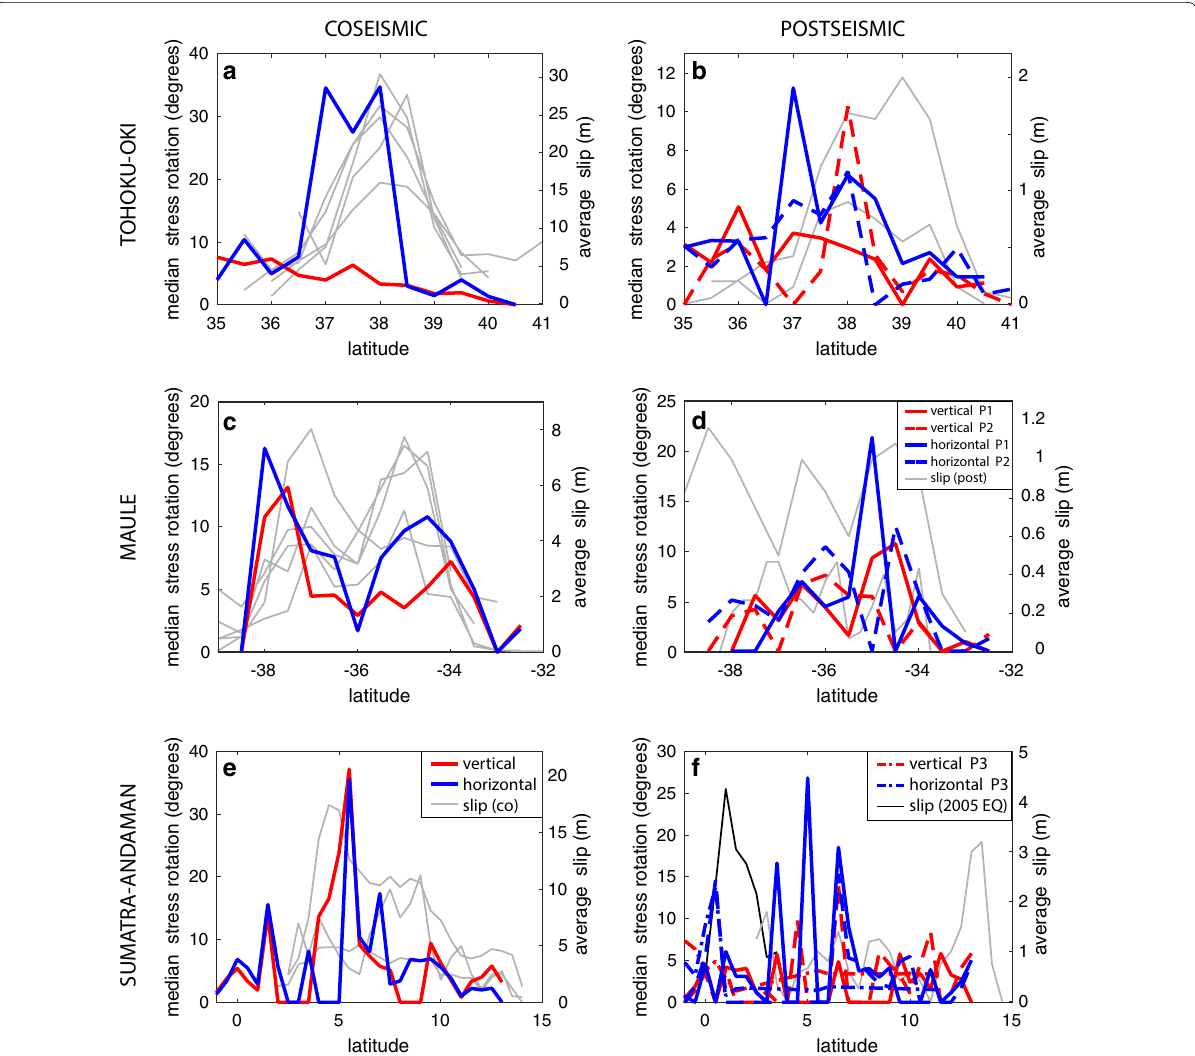
Fig. 5 Stress rotation as a function of latitude, a proxy for along-strike distance. The median vertical ( red ) and horizontal ( blue ) stress rotation is found for all inversion bins in 0.5° latitude intervals. Multiple realizations are performed by sampling a rotation for each bin from its bootstrap uncertainty, and the median is set to zero if it is not significantly different from zero at 1-sigma uncertainty. Gray curves indicate average mainshock slip or average afterslip as a function of latitude, from the same models as in Fig. 4. a Tohoku-Oki earthquake coseismic stress rotation, b Tohoku- Oki earthquake postseismic stress rotation, P1 shown as solid lines and P2 as dashed lines , c Maule earthquake coseismic stress rotation, d Maule earthquake postseismic stress rotation, P1 shown as solid lines and P2 as dashed lines , e Sumatra–Andaman earthquake coseismic stress rotation. f Sumatra–Andaman earthquake postseismic stress rotation, P1 shown as solid lines , P2 as dashed lines , and P3 as dash - dot